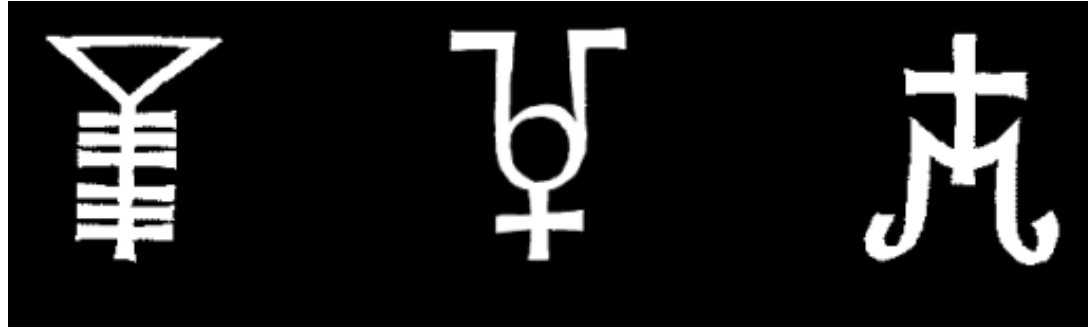
Figure 2. Visual targets used in Experiment